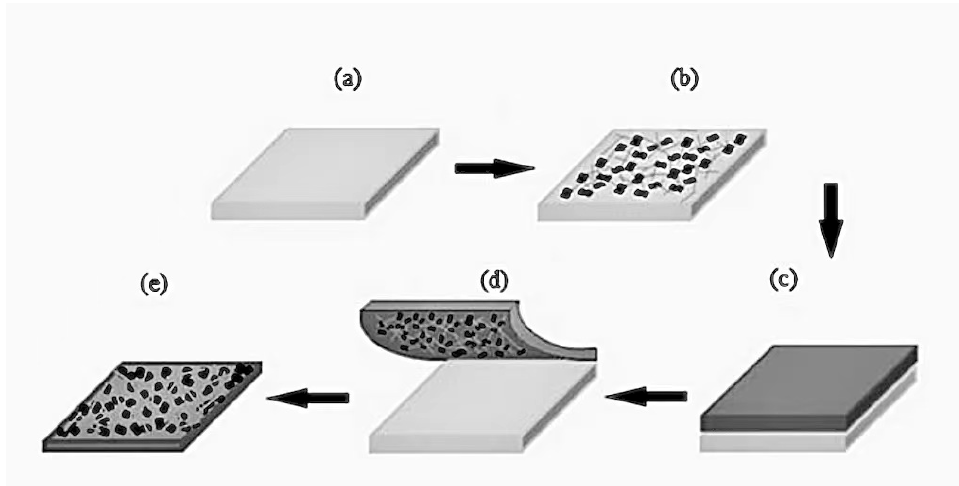
Figure 8. Schematic representation of nanocomposite thin film production: ( a ) glass substrate; ( b ) spin-coated glass with conductive material; ( c ) polymeric material-coated conductive glass; ( d ) removal of conductive polymeric film from glass; ( e ) self-standing conductive polymeric layer [9].